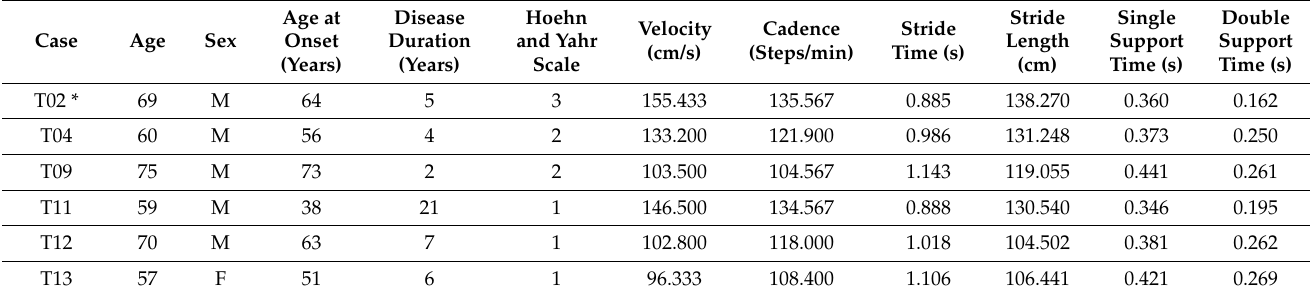
Table 1. Individual baseline demographics and gait